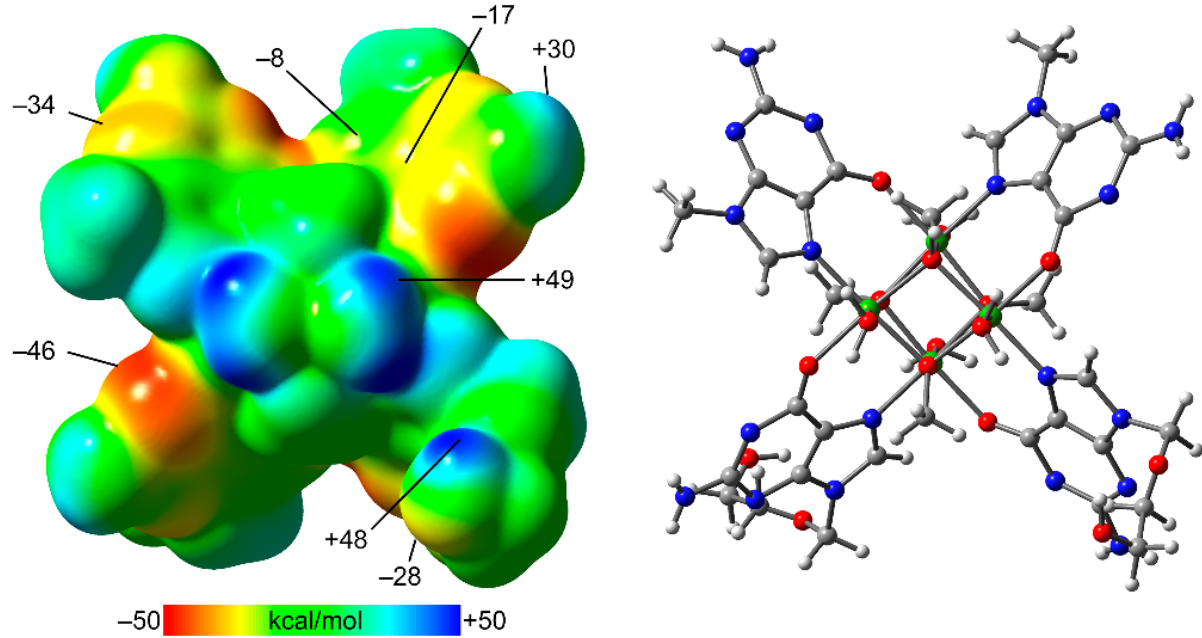
Figure 5. ( Left ) MEP surface of compound 1 at the PBE0-D3/def2-TZVP level of theory. The energies in kcal/mol. ( Right ) Representation of the molecule in the same orientation used to plot the MEP surface.